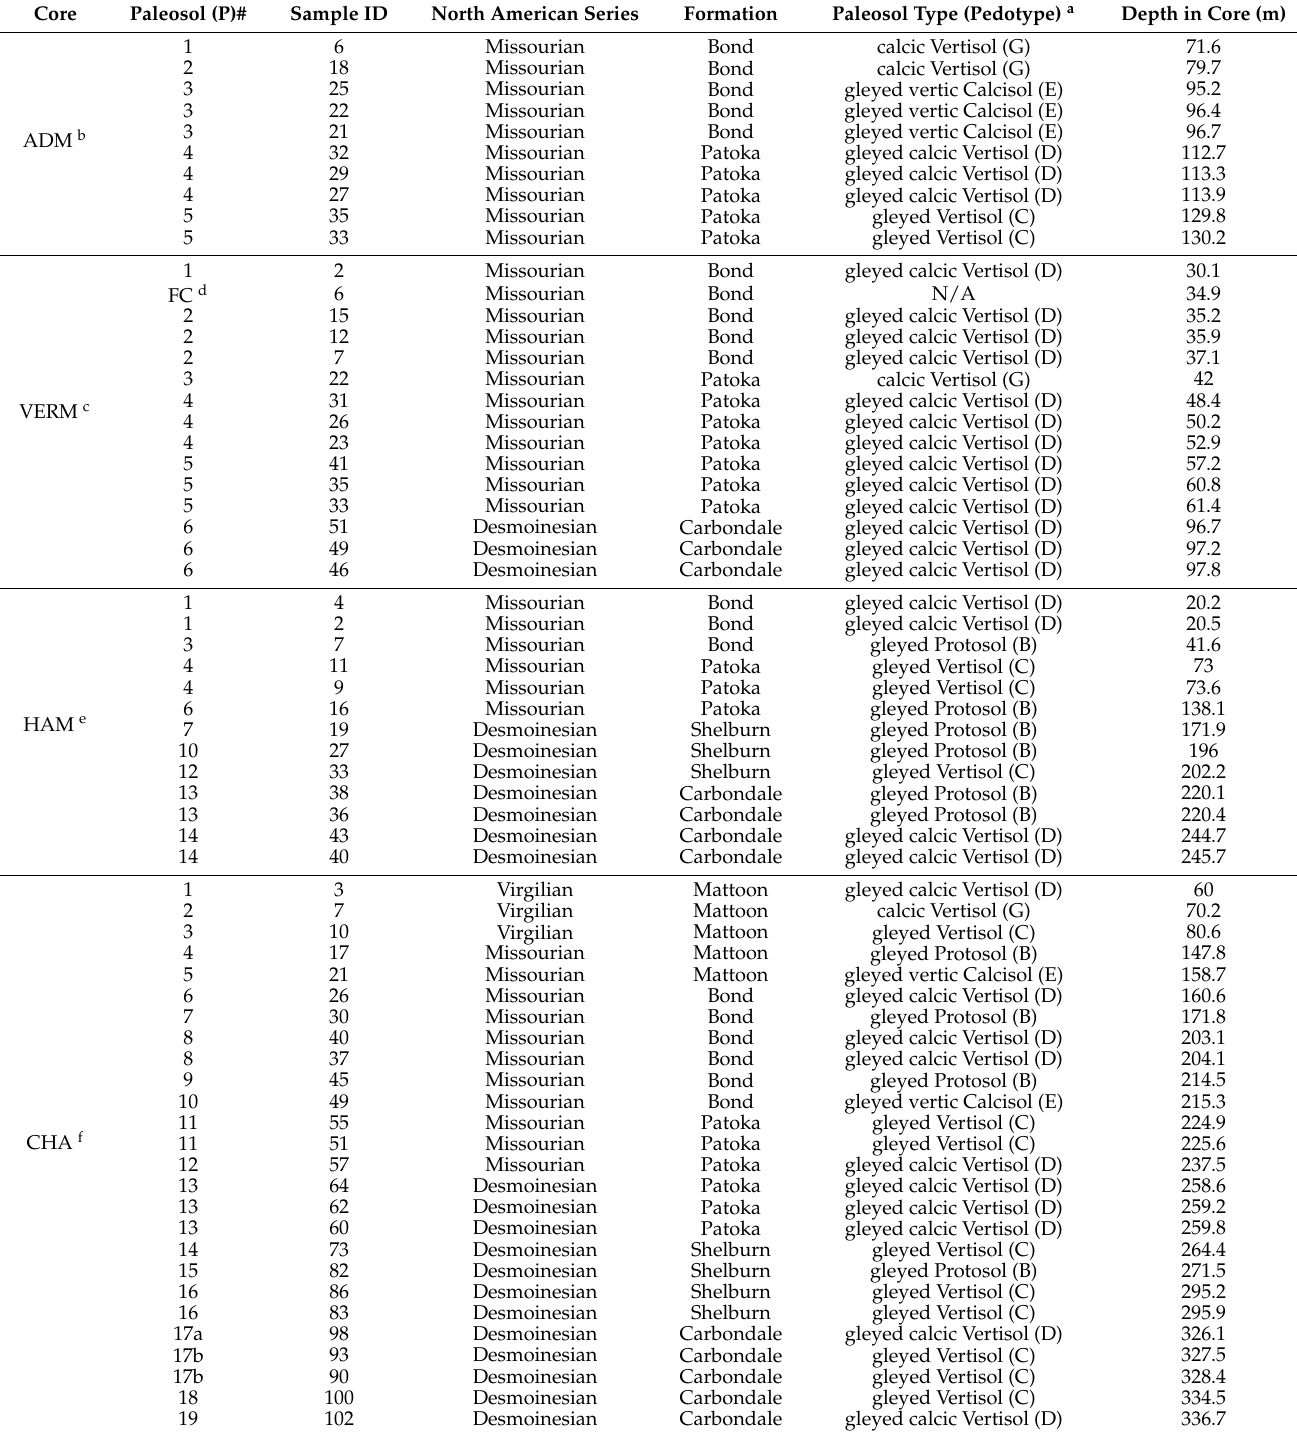
Table 1. Sample details from Illinois Basin